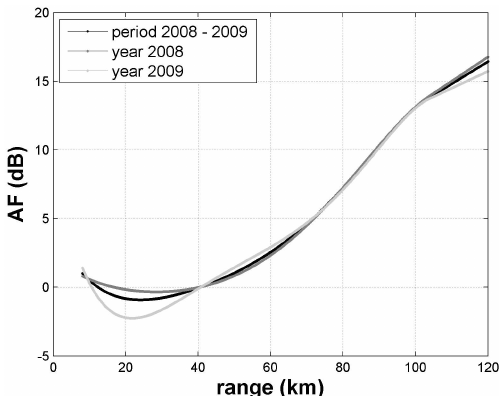
Fig. 12. AF trends with range evaluated for longer accumulation times (black, dark grey, and light grey refer to the period 2008– 2009, the year 2008, and the year 2009, respectively) and the an- tenna elevation angle of 1.5 ◦